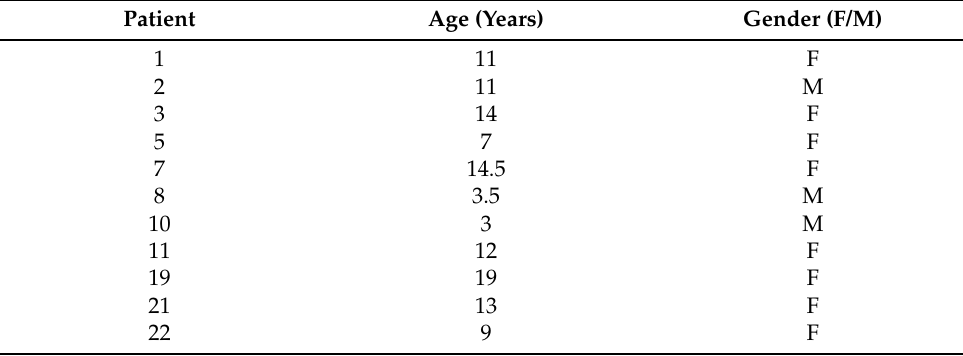
Table A1. This table shows patient information used in this